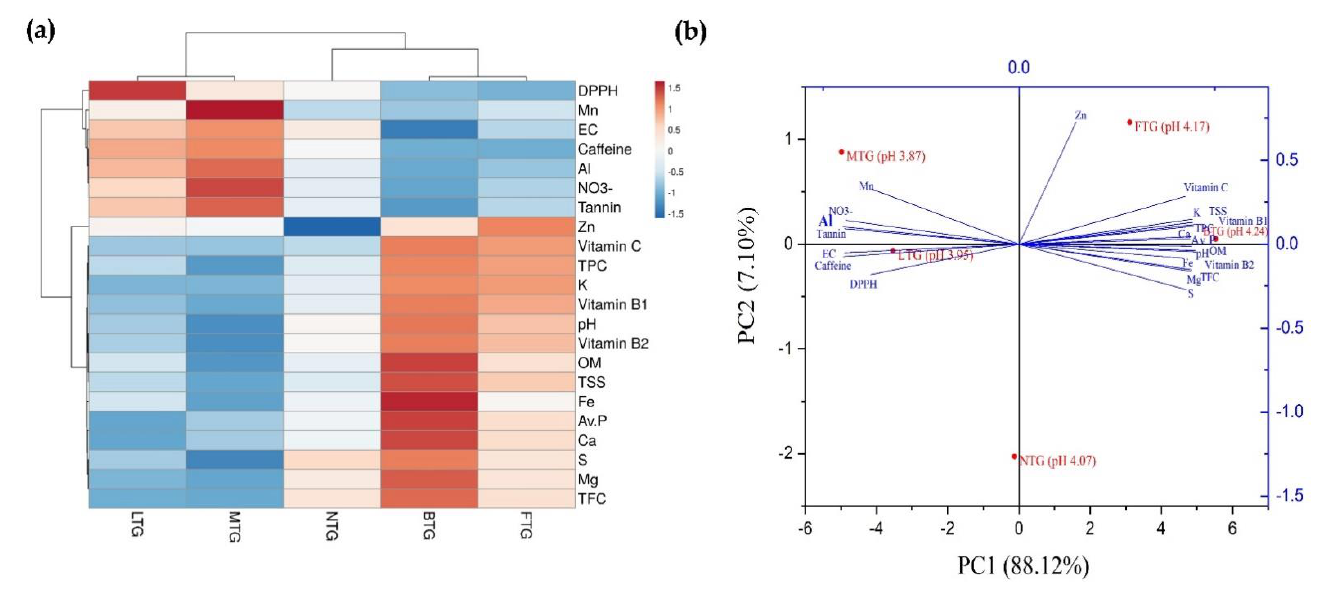
Figure 5. Biochemical and nutritional qualities of tea leaf as influenced by reduced soil pH. ( a ) Heatmap and ( b ) principal component analysis (PCA) shows the effect of long-term traditional fertilization on biochemical and nutritional quality of soils and tea leaves in BTG, NTG, FTG, LTG, and MTG tea gardens of Bangladesh.